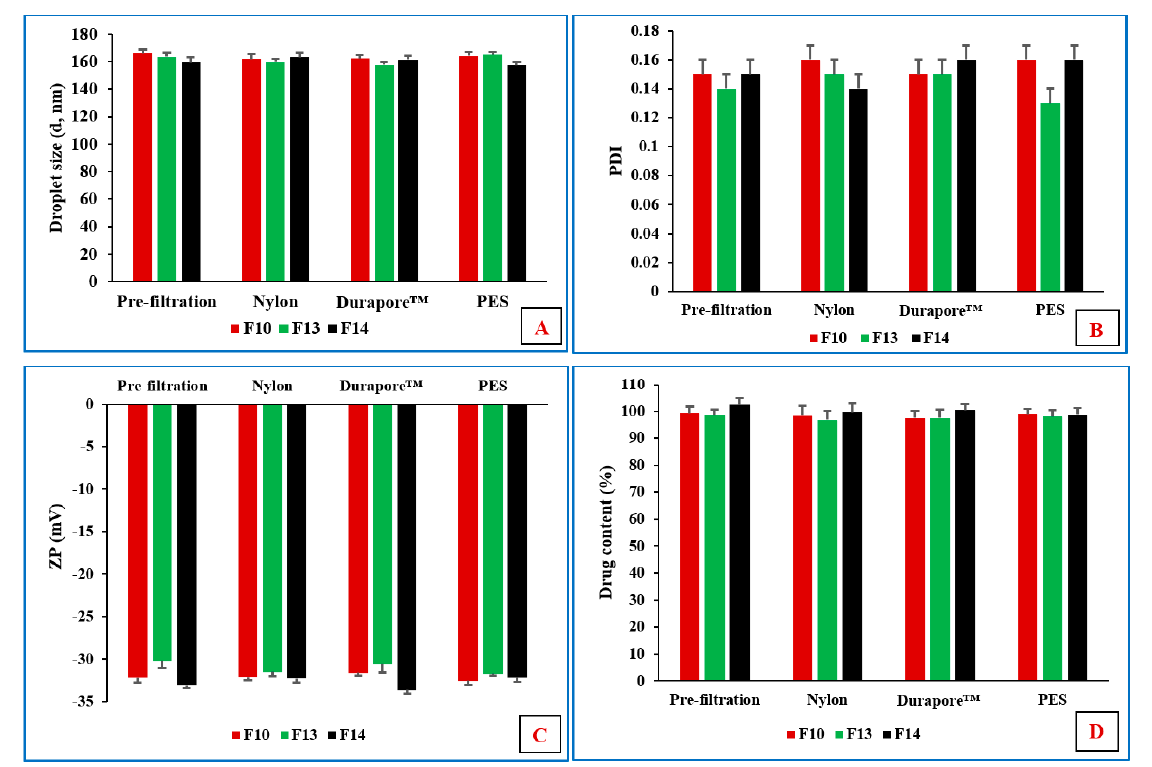
Figure 1. Effect of filtration on ( A ) droplet size (d, nm), ( B ) PDI, ( C ) zeta potential (mV), and ( D ) drug content (%) of F10, F13, and F14 formulations (mean ± SD, n = 3). Steam sterilization is probably the most widely used of all sterilization methods. As opposed to aseptic manufacture, terminal sterilization in the final dosage form container is the preferred approach from a regulatory point of view. Owing to the advantage as a terminal sterilization process, moist-heat sterilization was also investigated for the NE and NEM formulations. F10, F13, and F14 formulations were selected to evaluate moist- heat sterilization process stability based on a three-month stability study of the unsteri- lized formulations. The pre- and post-moist-heat sterilization physicochemical character- istics are presented in Table 5. The autoclaved formulations remained stable at RF and RT; DS, PDI, ZP, pH, and drug content did not show a significant ( p < 0.05) change in compar- ison to the pre-autoclaved formulation for one month. The sterilized formulations main- tained high negative ZP values ( ≥ 30 mV), reflecting a high negative surface charge for adequate droplet–droplet-repulsive forces, improving NE and NEM stability.